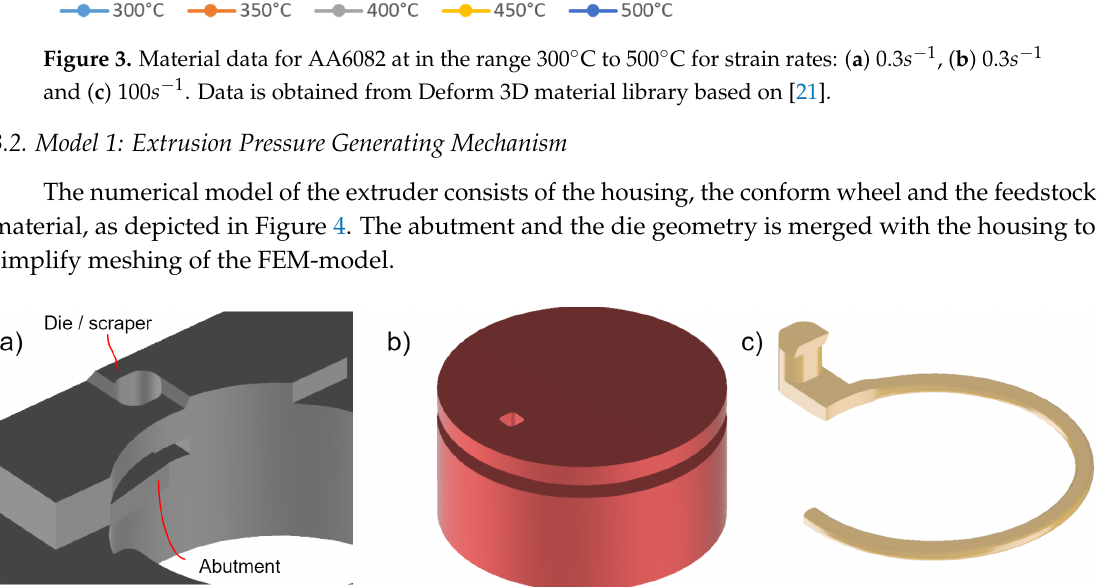
Figure 4. The geometry used for finite element method (FEM) model 1 as seen from below. ( a ) the housing, merged with the die and the abutment; ( b ) the conform wheel; ( c ) the feedstock